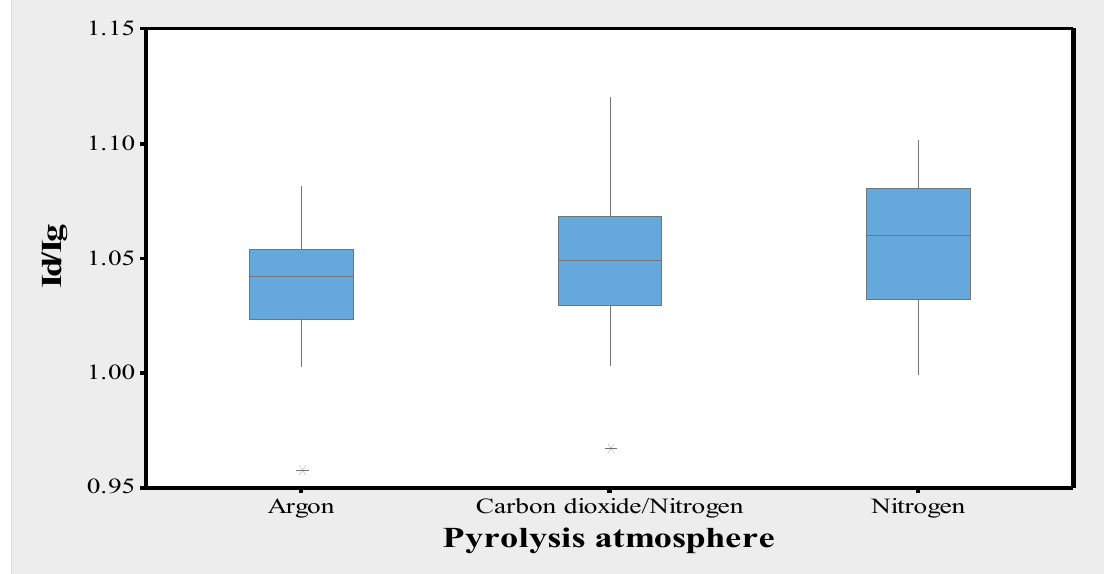
Figure 4. Conversion profiles of chars with CO 2 in HPTGA (The temperature in the legend indicates the HPTGA temperature and the gas atmosphere indicates the pyrolysis atmosphere in a high-pressure, high-temperature flow reactor (HPHTFR)).